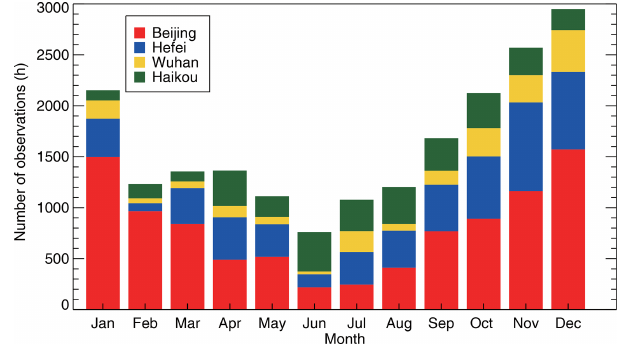
Figure 1. Monthly distribution of the number of Na observations measured by the four Na lidars during the period 2005 to